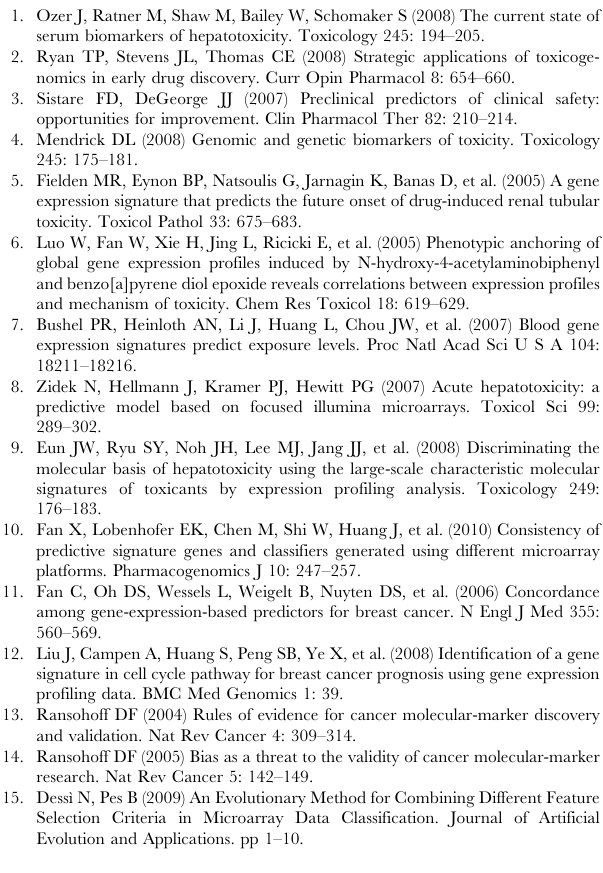
Table S1 Summary of the positive class compounds and experiments which defined Bile Duct Hyperplasia, Inflammation,